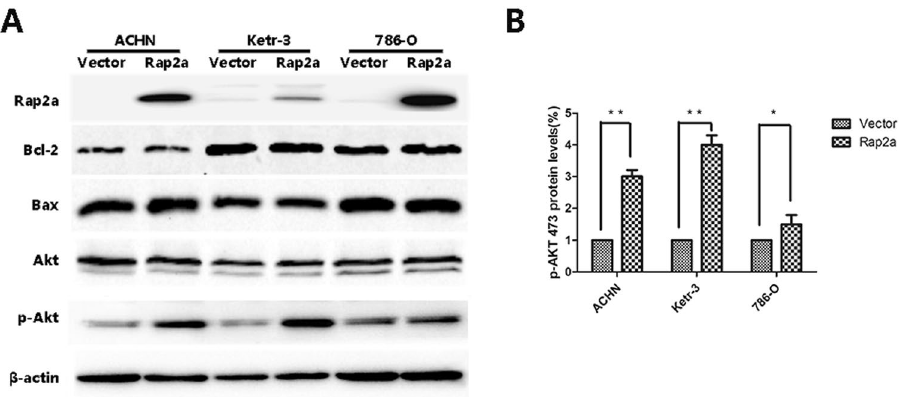
Figure 5. Akt phosphorylation involved in Rap2a-mediated migration and invasion of RCC cells. ( A ) Western blot analysis of the relative protein levels in RCC cells after Rap2a overexpression. The protein levels of Bcl-2, Bax and Akt had no significant difference between vector and Rap2a overexpression. However, p-Akt level was significantly increased after Rap2a overexpression. ( B ) Densitometric analysis of p-Akt473. The data are presented as mean ± SD from three independent experiments. * P < 0.05, ** P <